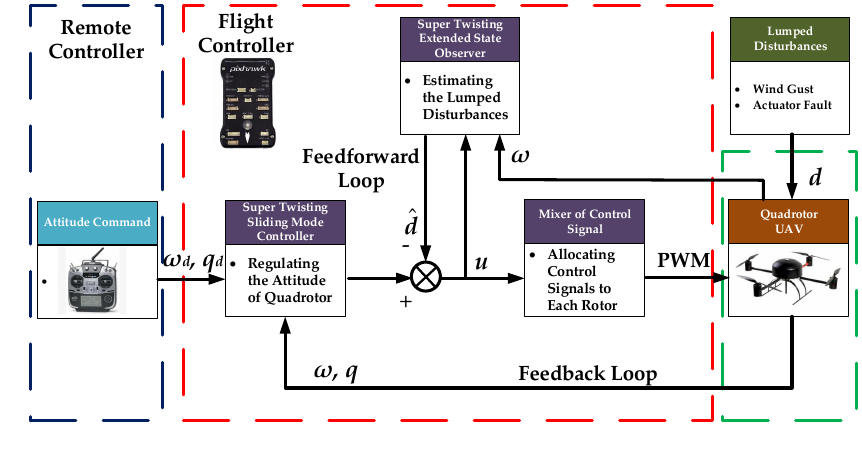
Figure 2. Block diagram of the proposed control